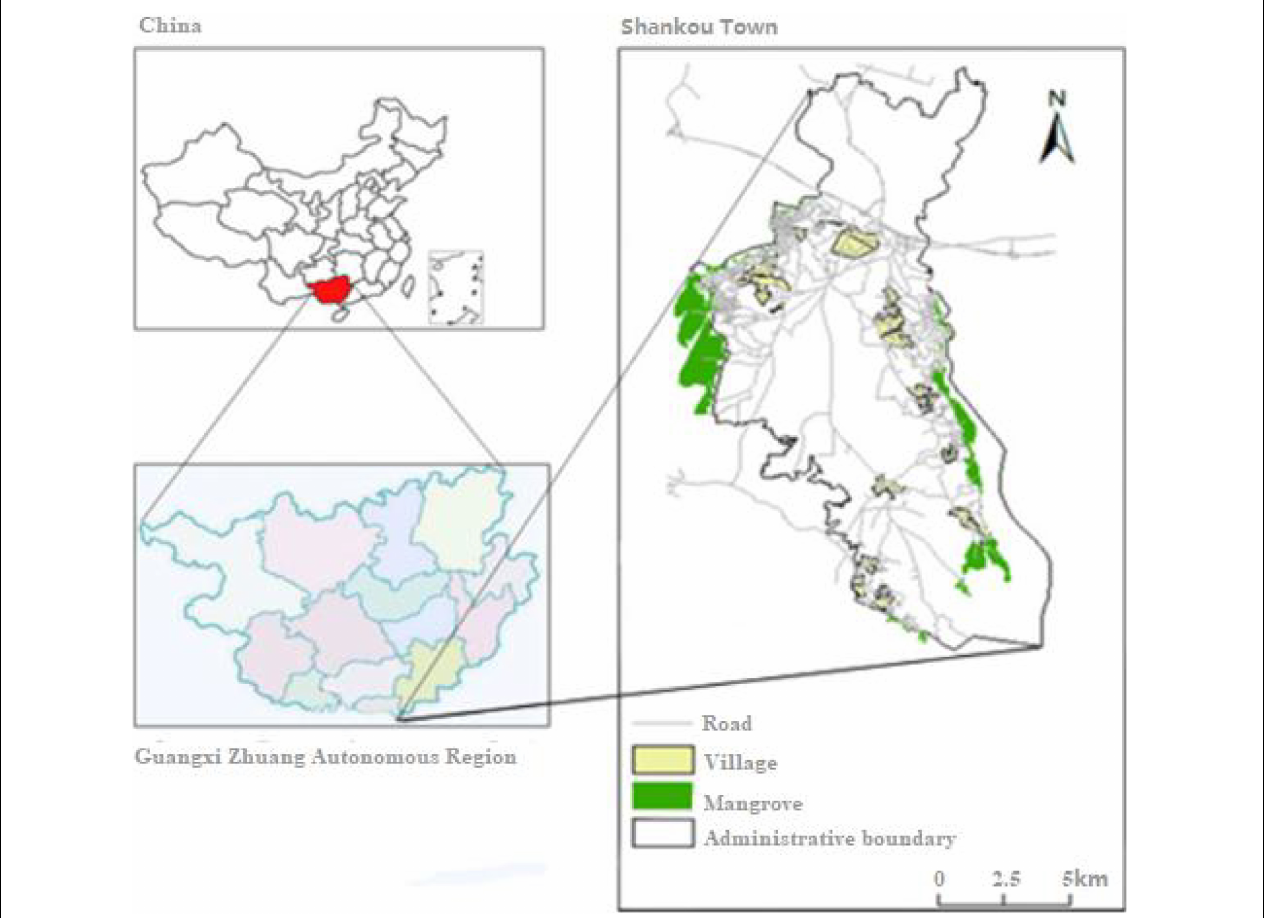
FIGURE 2 | Sketch map of the survey